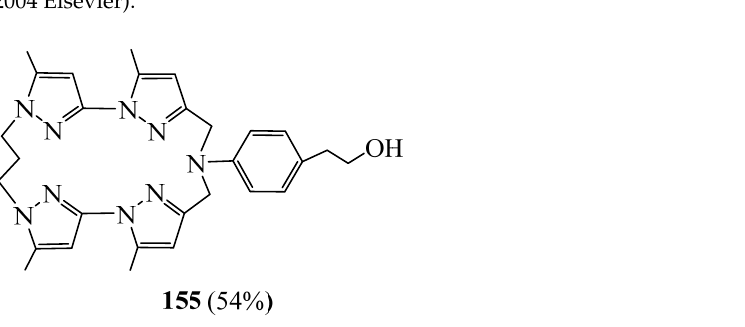
Figure 42. Tetrapyrazolic macrocycles 153 and 154 with one lateral arm. (Reprinted with permission from ref. [71] Copyright 2006 Elsevier; Reprinted with permission from ref. [71] Copyright 2004 Elsevier).